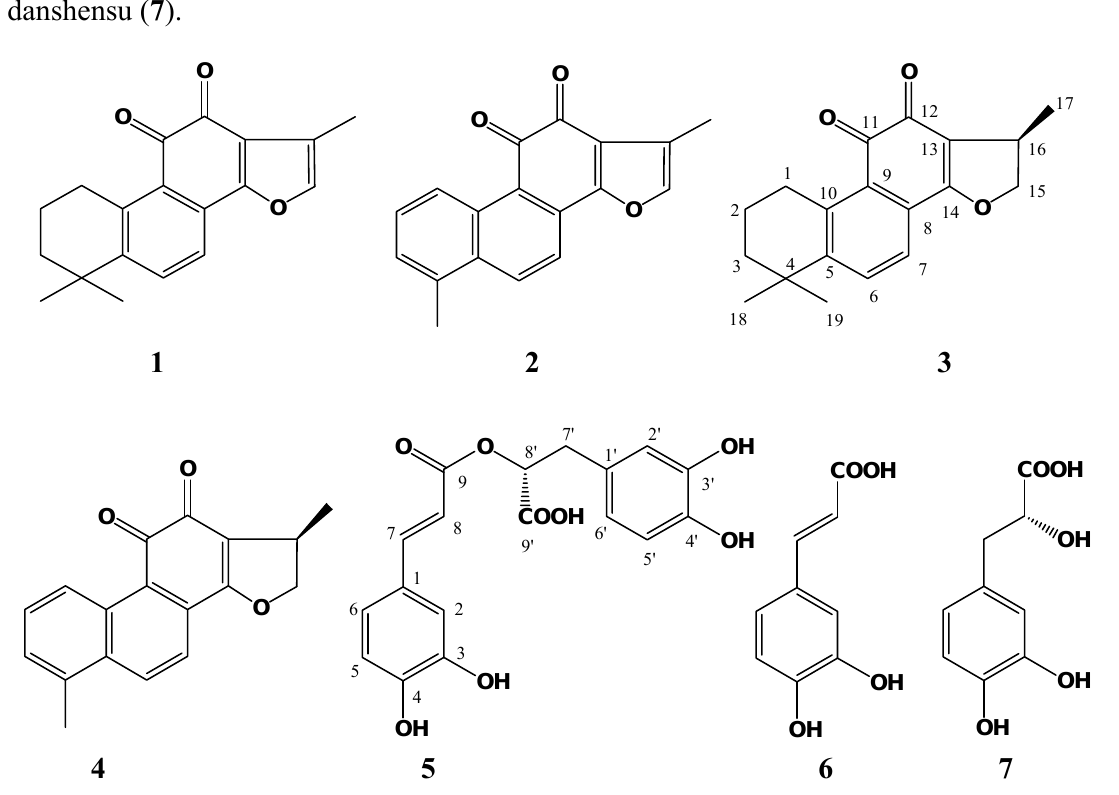
Figure 1. Chemical structures of the compounds: tanshinone IIA ( 1 ), tanshinone I ( 2 ), cryptotanshinone ( 3 ), dihydrotanshinone I ( 4 ), rosmarinic acid ( 5 ), caffeic acid ( 6 ), and danshensu ( 7